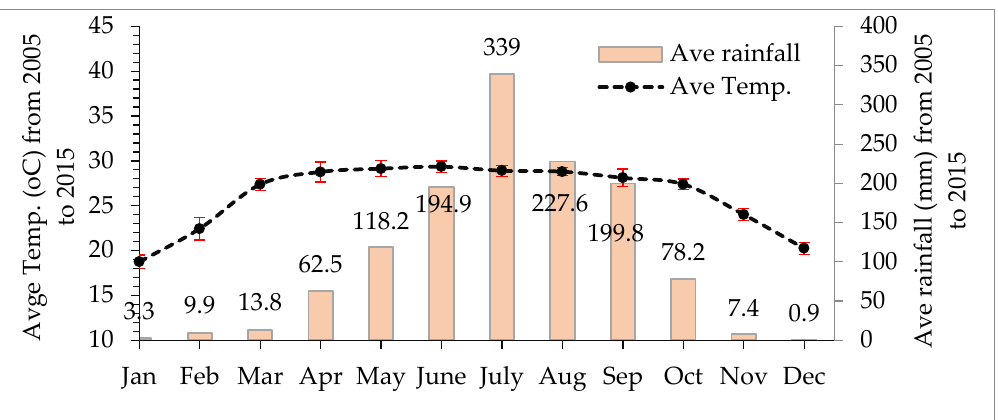
Figure 3. Monthly average temperature and rainfall of Dhaka city (2005 to 2015). Data source: Bangladesh Meteorological Department (2015).